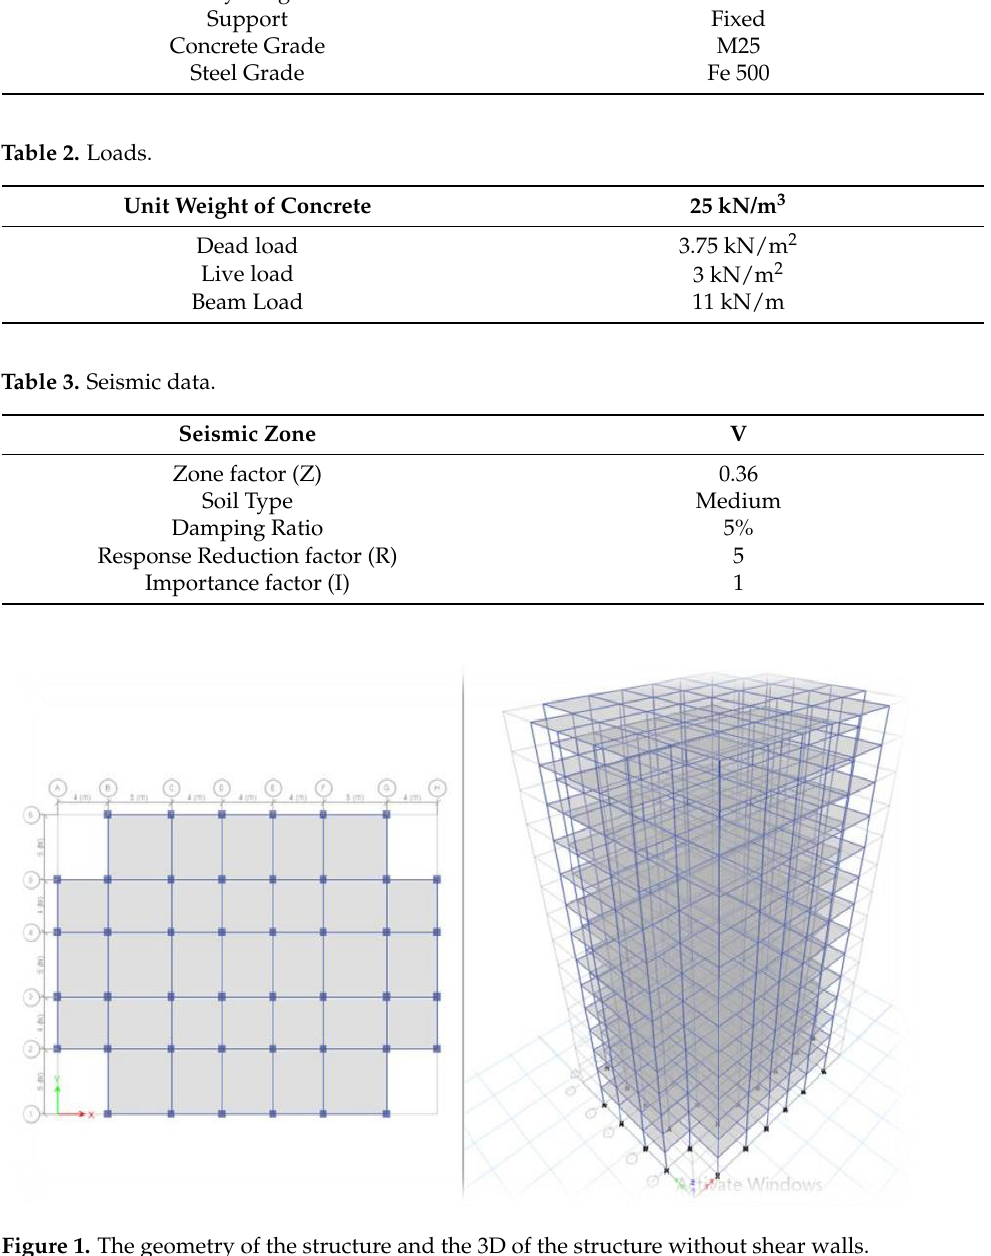
Figure 2. The geometry of the structure and 3D structure shear wall without opening. Figure 3. The geometry of the structure and 3D structure shear walls with vertical openings.